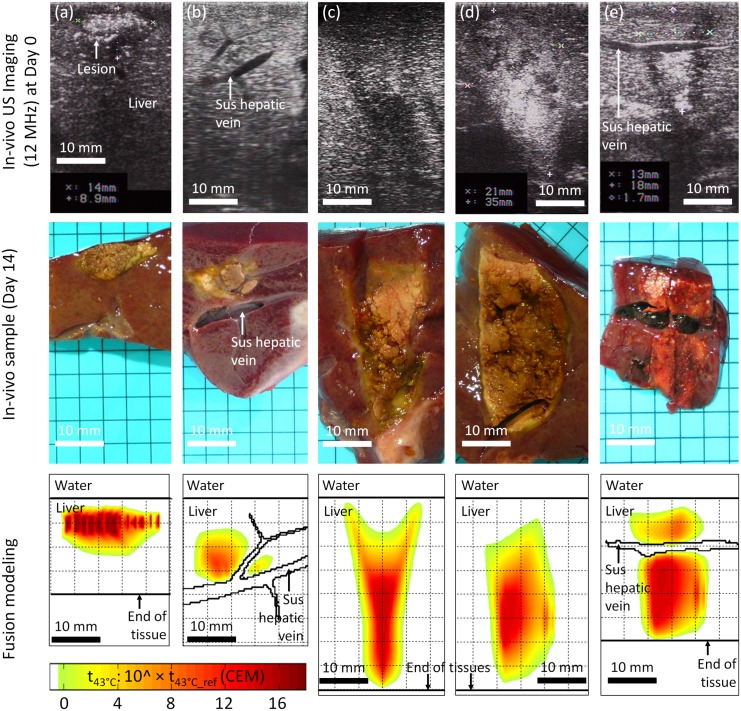
Preliminary in vivo validation of fusion modeling in a porcine model for 2 ultrasound focusing strategies: toroidal and spherical HIFU.Post-treatment fusion modeling merged real in vivo liver motions acquired intraoperatively during HIFU treatments and realistic geometries of sus hepatic veins. Macroscopic analyses were performed on liver tissue samples removed 14 days after HIFU sessions. (a to b) Spherical focusing: 2 examples of in vivo HIFU ablations generated with a juxtaposition of 7x7 lesions during breathing (total exposure time: 8 minutes, Pac = 30 W); (a) in moving homogeneous liver tissues; (b) in moving liver tissues in presence of a sus-hepatic vein. (c to e) Toroidal focusing: 3 examples of in vivo HIFU ablations generated with one single exposure during breathing (total exposure time: 40 seconds, Pac = 50 W); (c) in stationary homogeneous liver tissues (40-second apnea); (d) in moving homogeneous liver tissues; (e) in moving liver tissues in presence of a sus-hepatic vein.